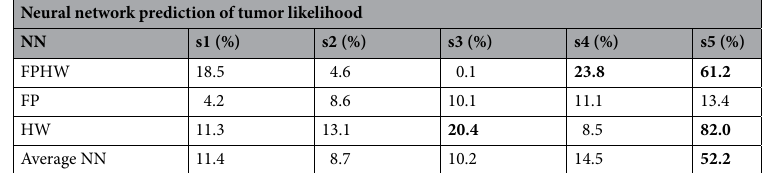
Table 4. Neural network (trained on k-means) prediction of tumor likelihood for five spectra from regions are shown to be rich in tumor tissue by histopathology, but predicted to be “healthy” by k-means. Likelihoods of tumor > 20% appear in bold. Figure 4 shows these 5 spectra along with average spectra from regions classified as 0% and 100% tumor.